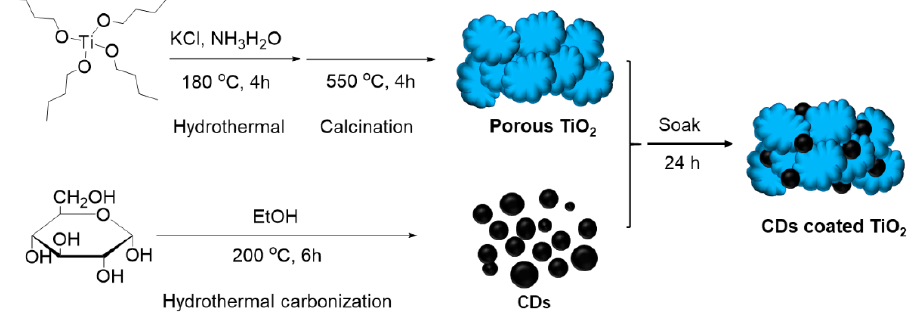
Scheme 1. Schematic diagram of hybrid TiO 2 /CDs preparation